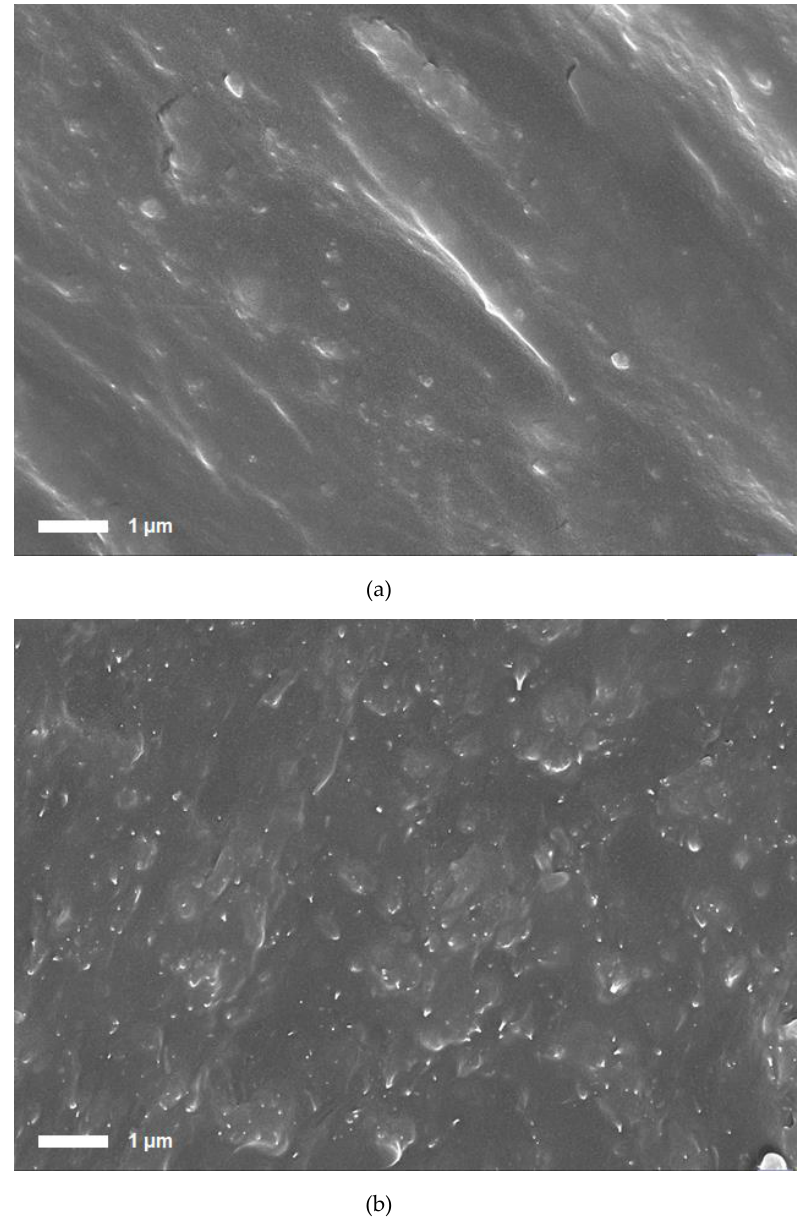
Figure 2. Scanning electron micrographs of ( a ) the pellet and ( b ) the filament of the MWCNT/TPU composite.